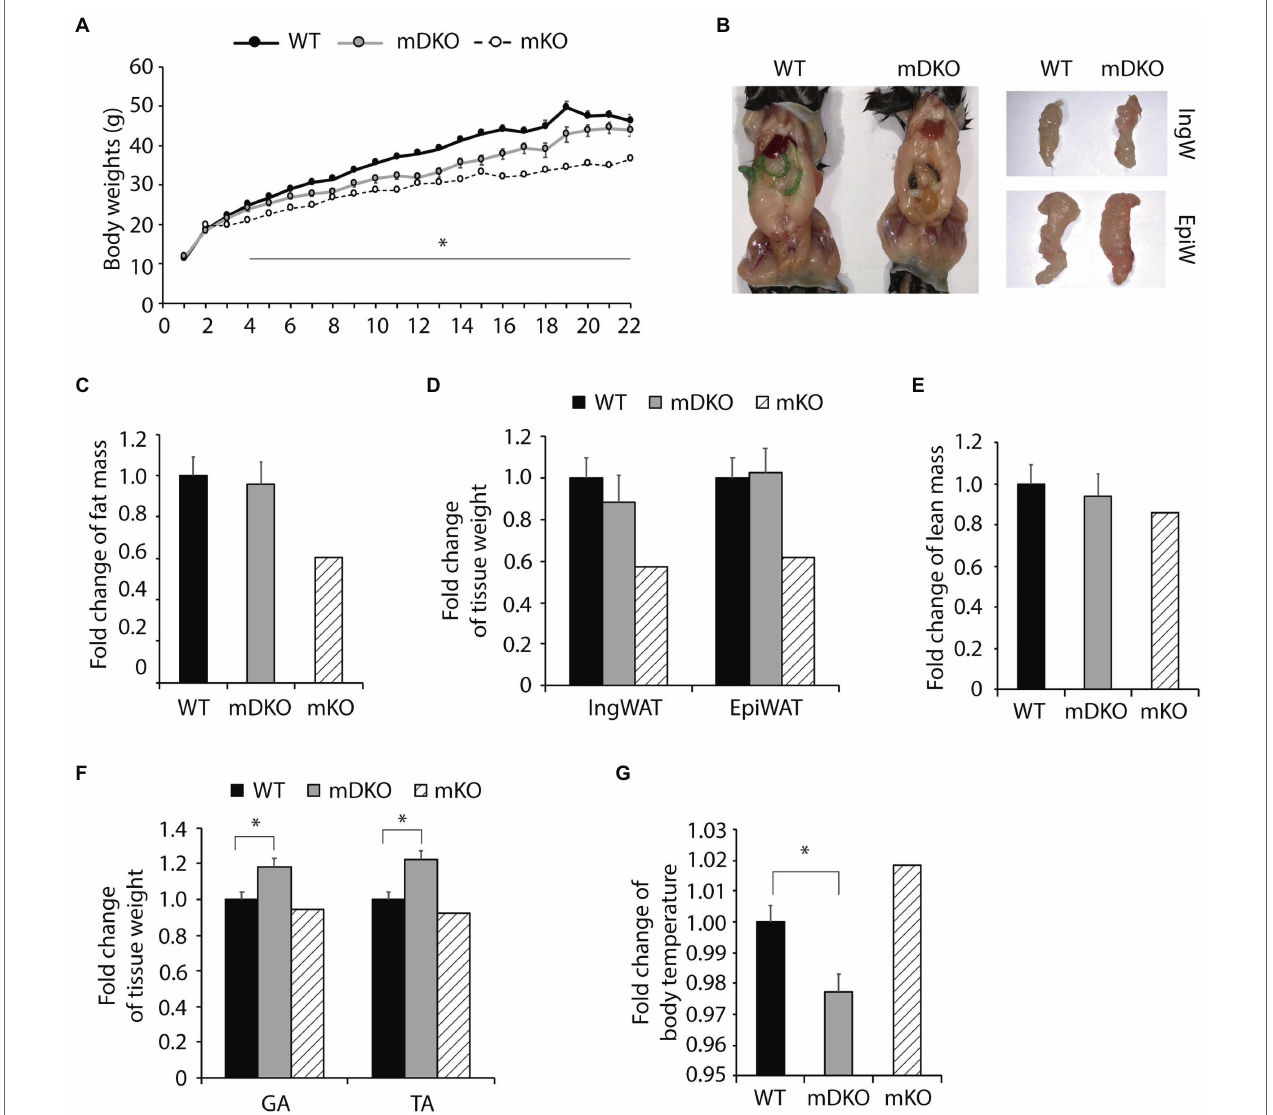
FIGURE 2 | Loss of OGT and IL-15r α in skeletal muscle diminished the lean phenotype observed in OGT single knockout mice. (A) Weekly body weights of WT and mDKO mice during 22 weeks of HFD feeding. HFD feeding started at 4 weeks of age. Values are means ± SEM, n = 11–14. (B) Representative images comparing abdominal, inguinal (IngW), and epididymal (EpiW) white adipose tissue depots from WT and mDKO mice. (C) Fat composition and (D) weights of inguinal (IngW) and epididymal (EpiW) white adipose tissue depots of WT and mDKO mice after 22 weeks of HFD feeding, n = 8–11. (E) Lean composition and (F) muscle weights of gastrocnemius (GA) and tibialis anterior (TA) muscles of WT and mDKO mice after 22 weeks of HFD feeding, n = 8–11. (G) Rectal temperature of WT and mDKO mice, n = 8–11. Values are normalized to WT means. * p < 0.05 when compared to WT. Values of striped bars are means from 5 muscle-specific OGT knockout mice (mKO) for